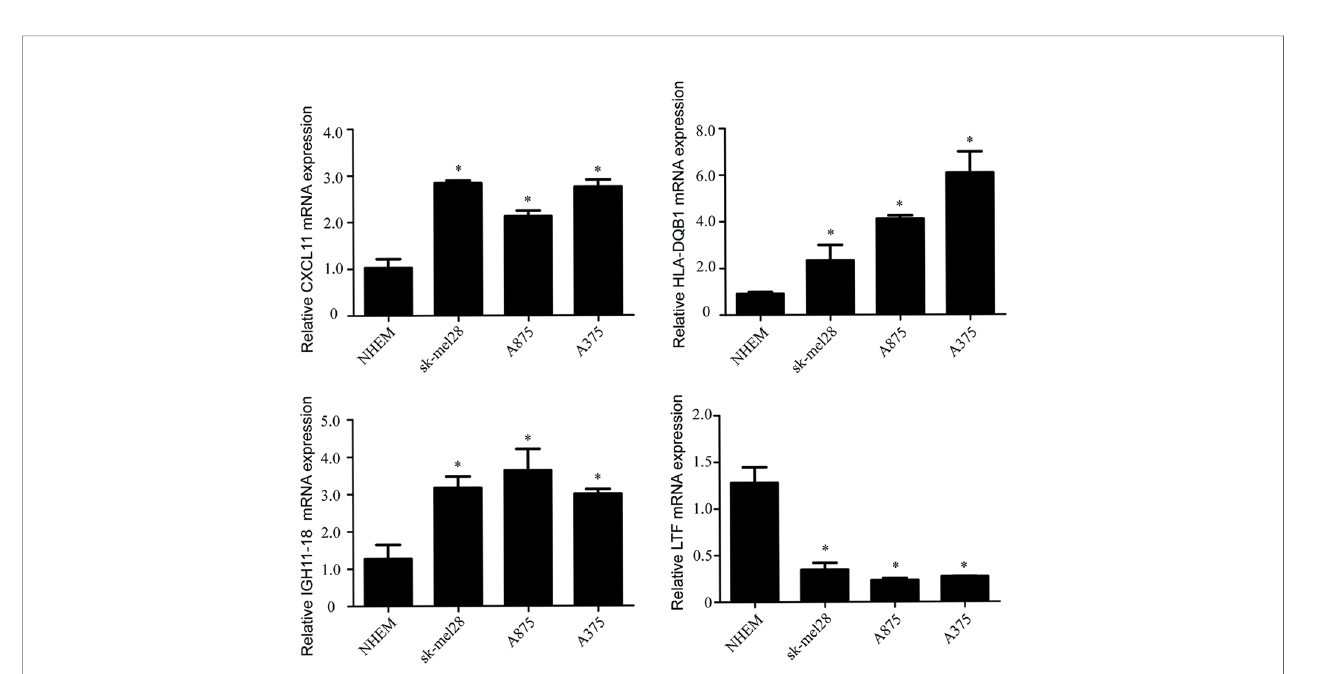
FIGURE 9 | The mRNA levels of IGHV1-18, CXCL11, LTF and HLA-DQB1 in melanoma cell line A375, A815, SK-MEL-28 and NHEM. Data are expressed as mean ± SEM. *P < 0.05. NHEM, normal human epidermal